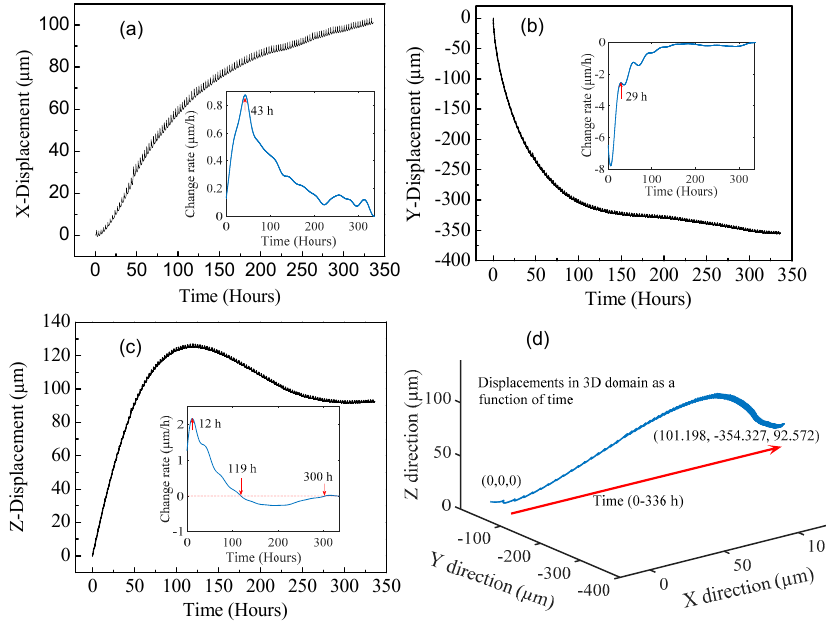
Figure 7. Real-time monitoring of 3D displacements between the long square brick of mortar and the steel base plate during the mortar curing/drying process. ( a – c ) Displacements versus time data for the X , Y , Z coordinates, respectively. The insets are plots of the time derivatives of the displacements as a function of measurement time for the X , Y , and Z directions. ( d ) Measured displacements plotted in the 3D domain parameterized by a time variable. The coordinate system used in the experiment was the same as the XYZ coordinate system shown in Figure 5a. The displacements along the X , Y , and Z directions revealed the interfacial sliding along the X direction, the buckling along the Y direction, and the debonding along the Z direction between the mortar and the steel base plate, respectively.